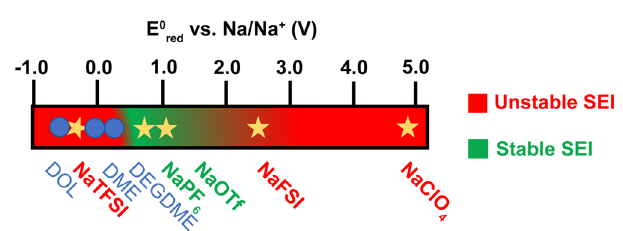
Fig. 3 | Schematic of the calculated reduction potentials of salts (stars) and solvents (dots). The green and red regions show the optimum and poor salt reduction potentials for building a uniform